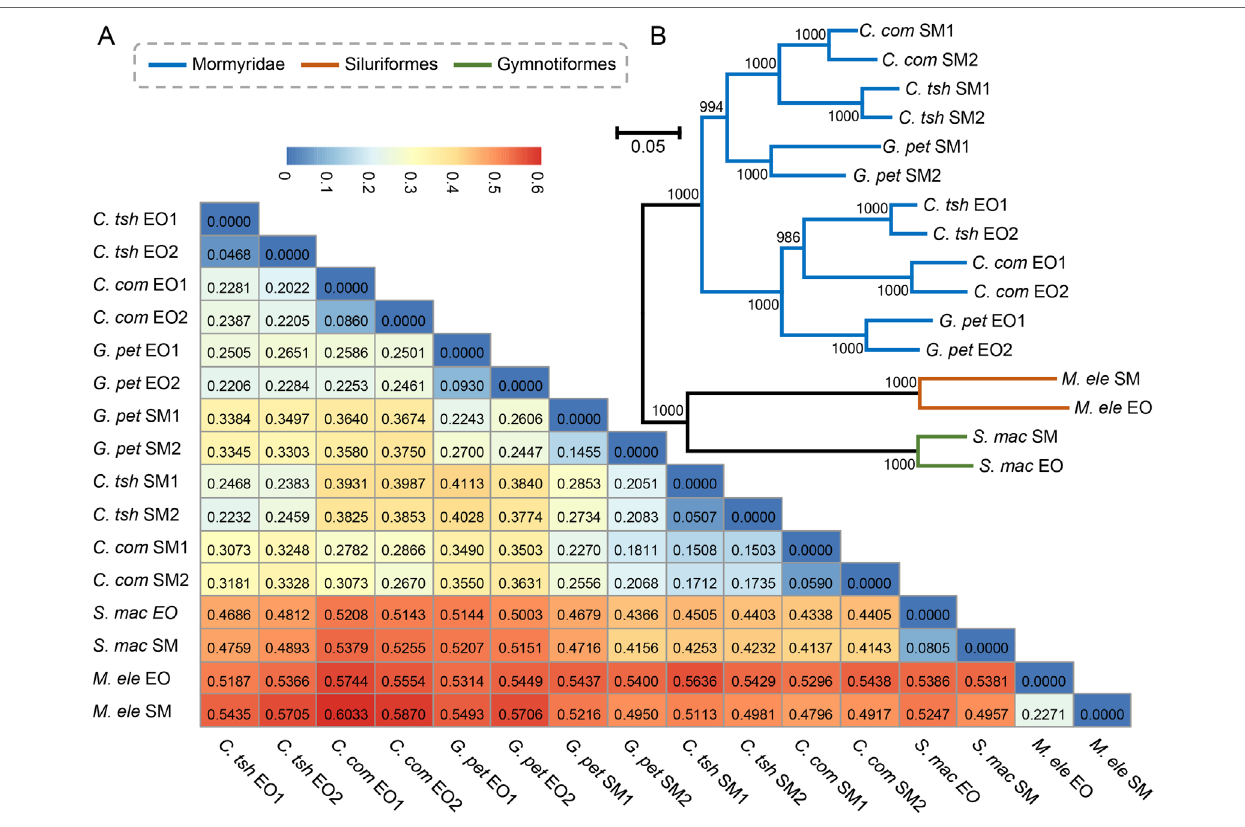
FIGURE 3 | Paired distance matrix and expression phylogenetic analysis of EO and SM expression profiles. (A) Based on the gene expression profiles of the SMs and EOs, a paired distance matrix was constructed based on pairwise distance matrices (1- ρ ). The ρ here means Spearman’s correlation coefficient. (B) NJ analysis of expression level of the SM and EO based on the matrix in part A. The numbers following EO or SM denote the sample